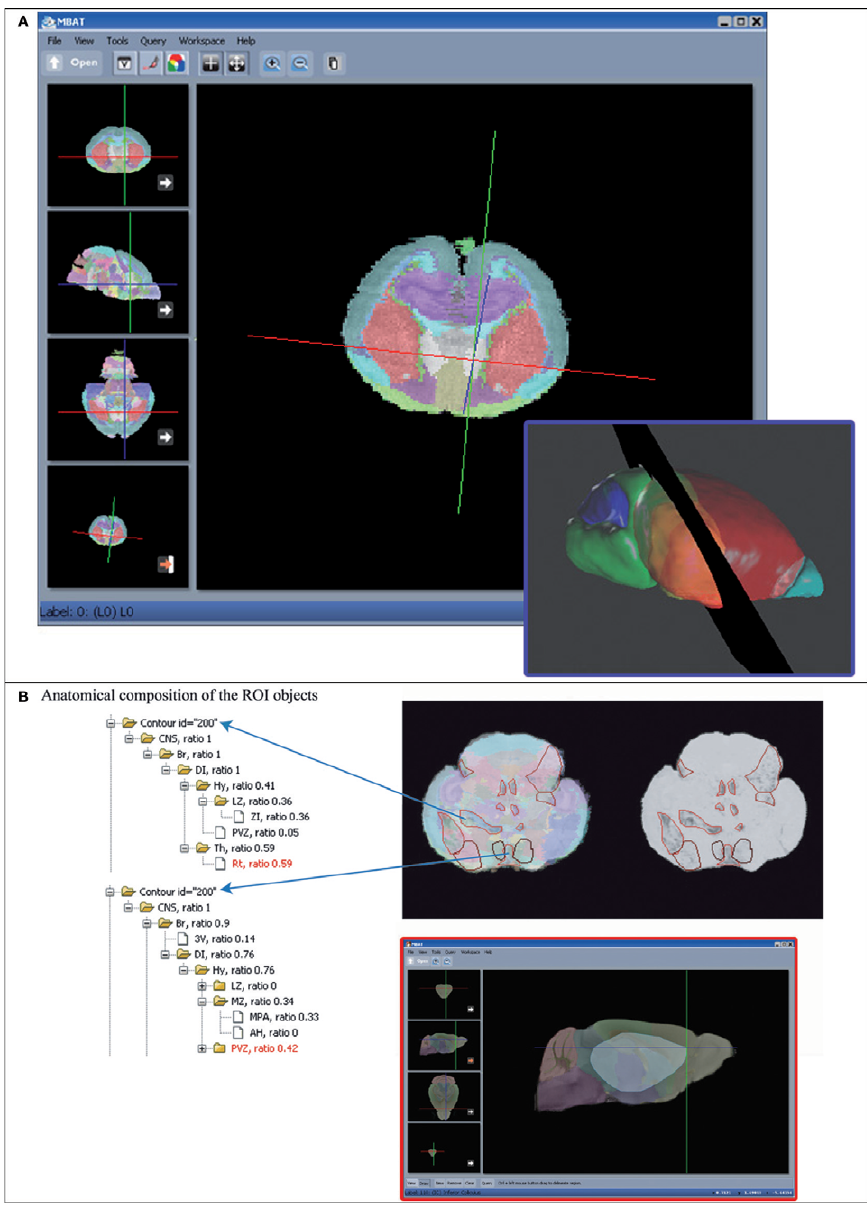
Figure 3 | Local atlas-based data management facilitates data correlation via several atlas tools developed in the BIRN project. (A) MBAT allows spatial query with manually drawn polygons. Based on the intersection of the polygon and the anatomi- cal delineation provided by the atlas, the anatomical composition within the ROI can be determined, thus enabling the retrieval of information associated with the atlas coordinates or anatomical concepts. Once the user’s data is brought into the atlas space, the contours outlining the regions of interest can be mapped to the brain anatomy. (B) The ROI management described in Lee et al. (2007) employed a similar vector organization as the polygon method used for spatial query in MBAT (inset). Bringing the data into a common standard space not only facilitates data visualization, but also allows one to use the atlas as an interface for reusing and correlating other data derived from the same